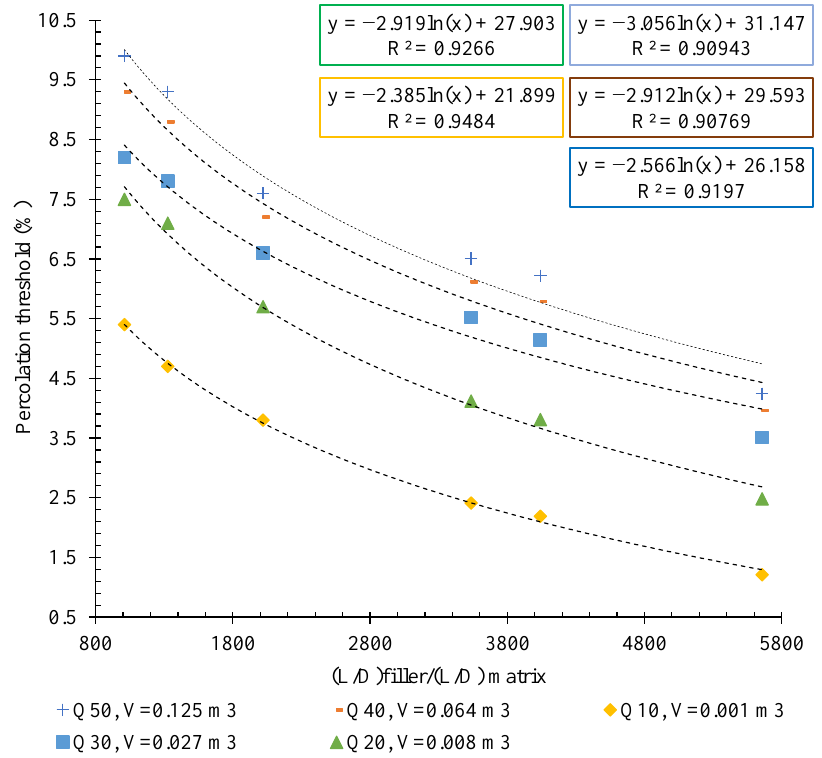
Figure 14. The relative aspect ratio of the carbon-based fillers vs. percolation threshold for the specimens with different volumes.